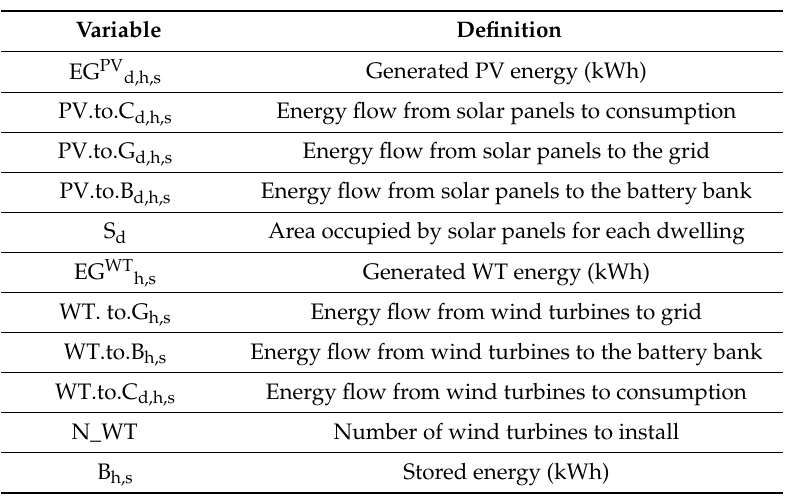
Table 5. Variables related to physical